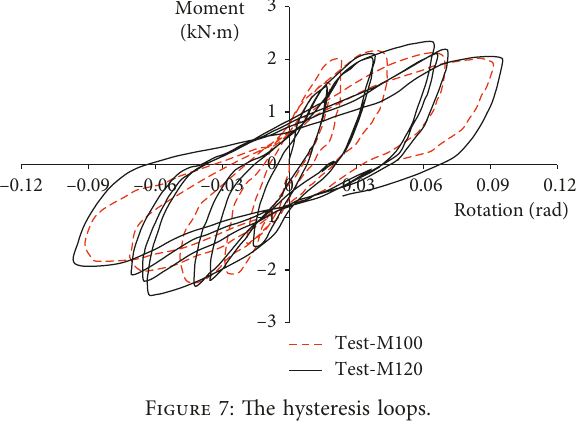
Figure 7: The hysteresis